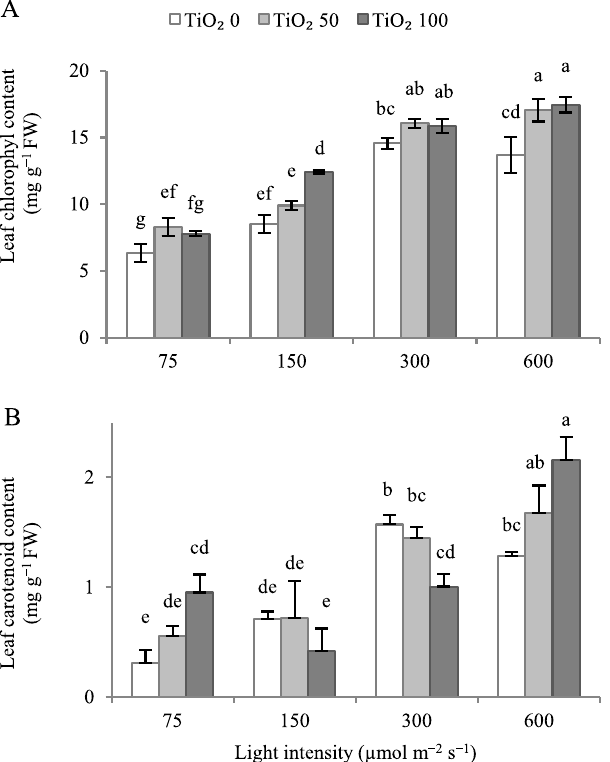
Figure 4. Effect of cultivation light intensity (75, 150, 300 and 600 µmol m −2 s −1 ) and spray treatment (once a week, and three times in total) with titanium dioxide (TiO 2 ) nanoparticles (open, grey, and dark grey for 0, 50 and 100 µmol L −1 , respectively) on leaf chlorophyll, and carotenoid contents of radish cv. Cherry belle plants. Six replicate plants were assessed per treatment. Bars represent SEM. In traits, where the interaction of the two factors (light intensity, TiO 2 nanoparticle level) was significant, different letters indicate significant differences. FW, fresh